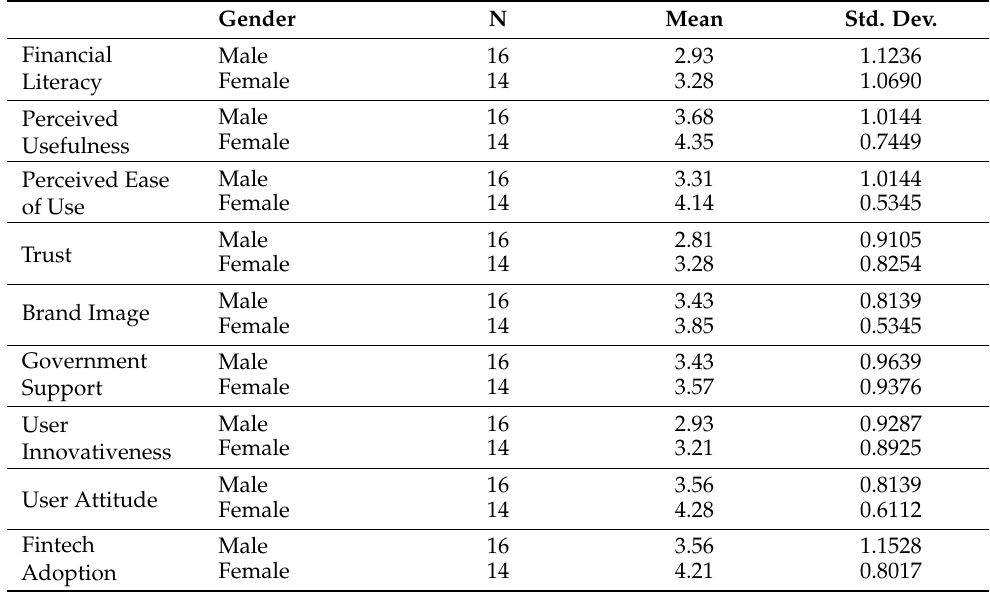
Table 12. Factor scores (grouped by